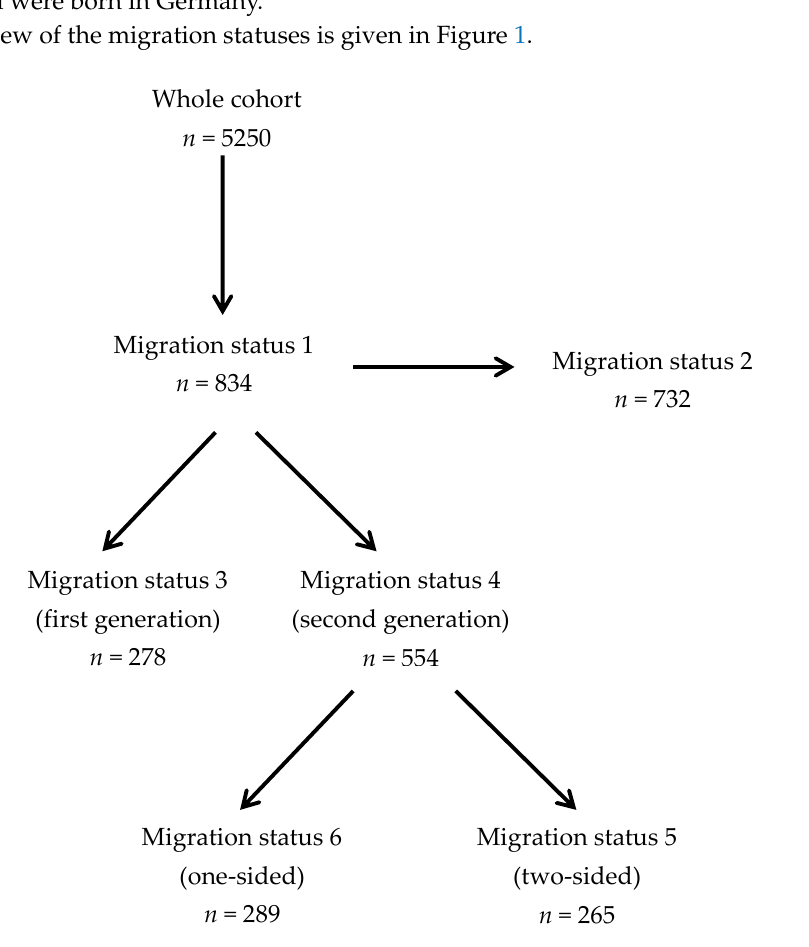
Figure 1. Overview over the different definitions of migration status.